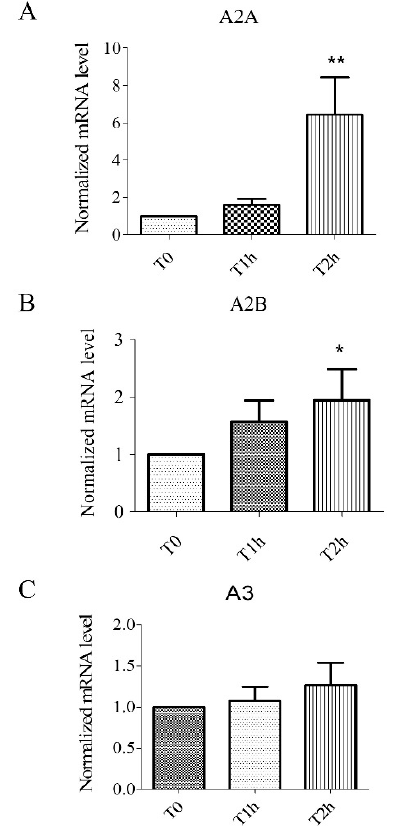
Figure 1. Expression of mRNA for adenosine receptors A2A ( A ), A2B ( B ), and A3 ( C ). Results are expressed with normalized mRNA levels using the following formula: 2 − ∆∆ CT as a function of time. Overexpression of mRNA for A2A and A2B receptors was observed. Results are expressed as means ± sem ( n = 6 / group). *: p < 0.05, **: p < 0.01, compared to a normoxic control group.